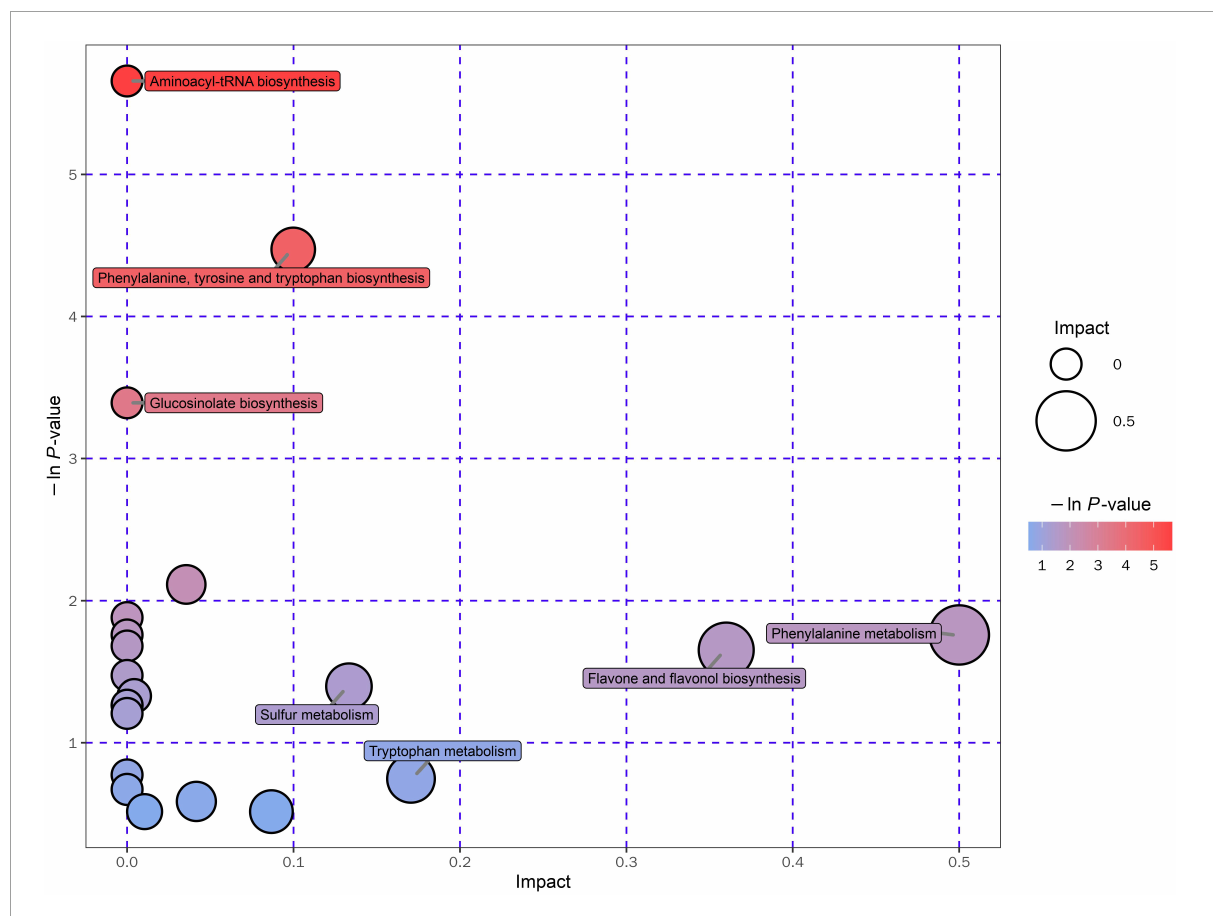
FIGURE6 Pathway analysis for 95% ethanol versus 75% ethanol